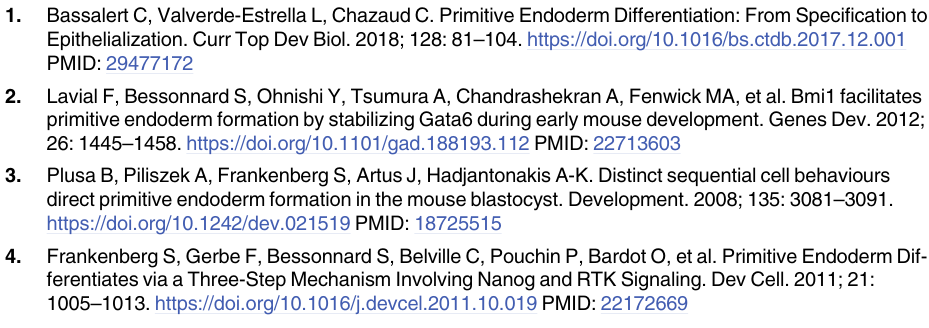
S1 Table. Numbers of analysed embryos. S2 Table. Numbers of analysed